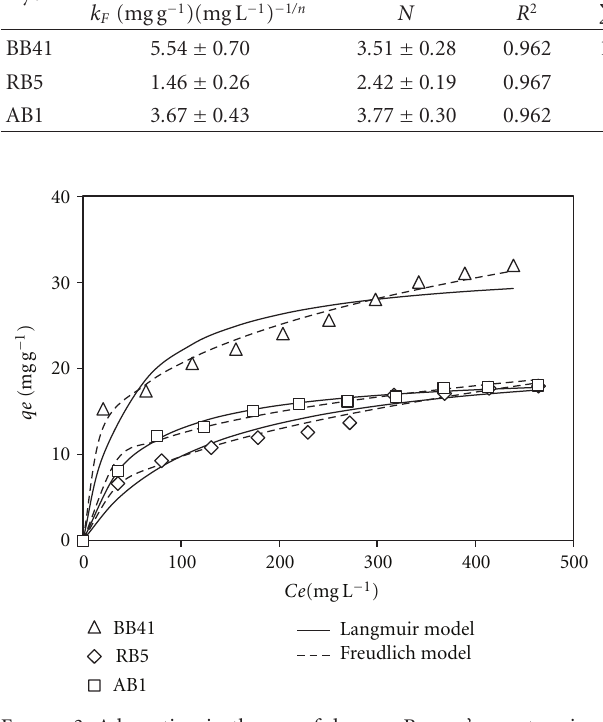
Figure 3: Adsorption isotherms of dyes on Brewer’s spent grains. Figure 4: Adsorption isotherms of dyes on Orange peel.